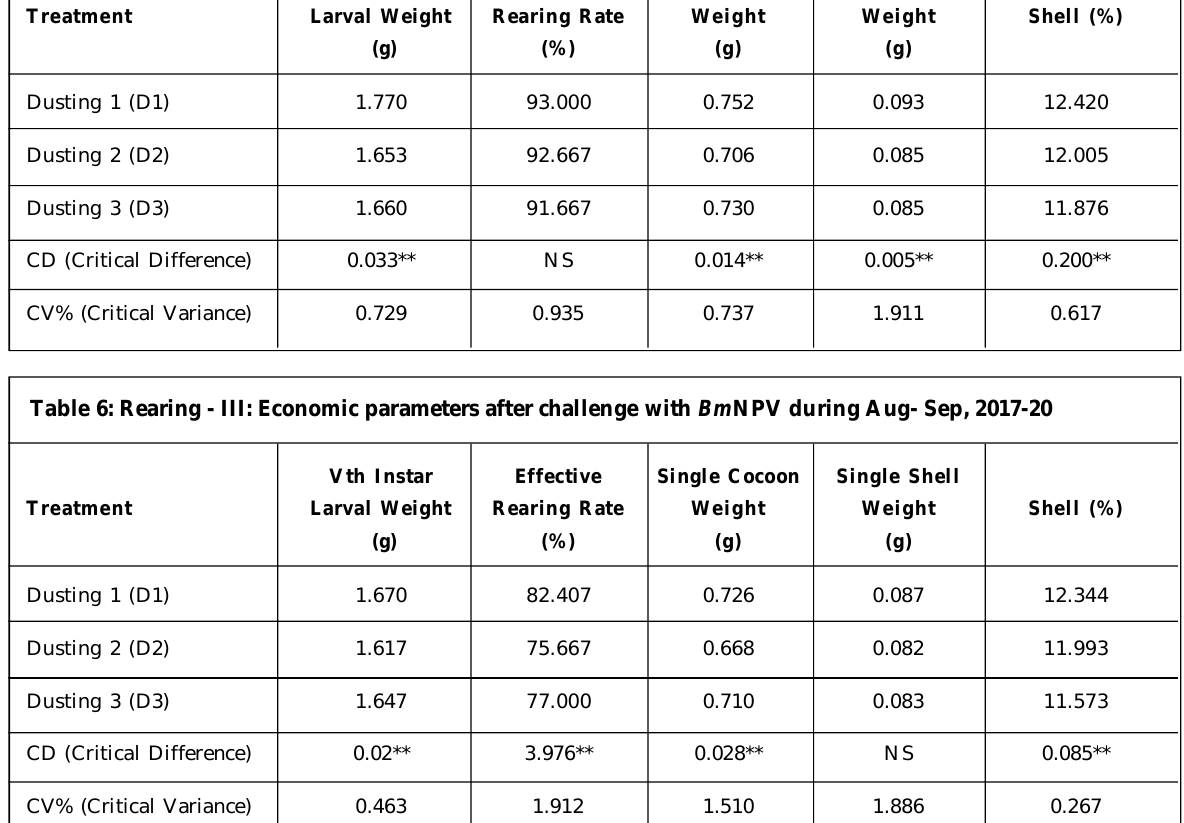
Table 5: Rearing - III: Economic parameters before challenge with Bm NPV during Aug- Sep, 2017-20. Vth Instar